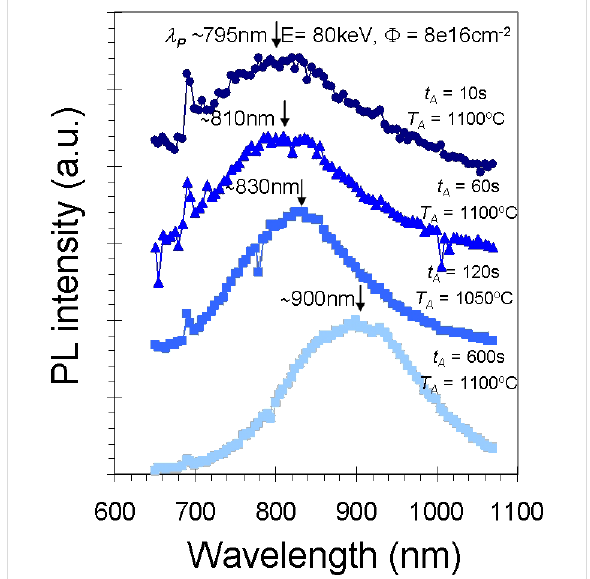
Figure 1: Evolution of the Si NC photoluminescence spectra (offseted for clarity) with high temperature annealing ( t A = time, T A = tempera- ture) for a thin (500 nm) oxide (on sapphire) implanted with Si + at E = 80 keV to a dose of 8 × 10 16 cm − 2 )